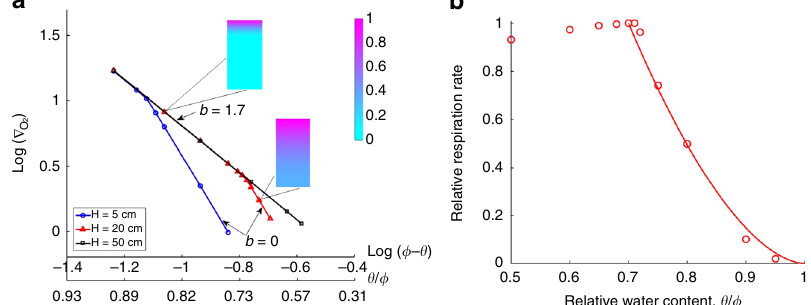
Fig. 3 Effects of O 2 distribution on the O 2 supply restriction factor, b , in the simulated homogenous soil cores with different depths. a Change of b with O 2 distribution, b = ω + 3.5, where ω is the slope of log( ∇ O2 ) − log( ϕ − θ ) curves (see Eq. 8 in Methods section). The gradient of O 2 at the soil – atmosphere interface, ∇ O2 , was calculated using the atmospheric O 2 concentration and the simulated O 2 concentration in the top numerical voxels of the soil cores. The inset plots show the distributions of the relative O 2 concentration with respect to the atmospheric O 2 concentration under different relative water contents ( θ / ϕ = 0.85 and 0.68). SOC and microorganisms were completely collocated in the soil cores as in Fig. 2a. b Comparisons between the moisture function, f m , and the simulated heterotrophic respiration (HR) – moisture relationship obtained by the microscale model (see Methods section) for the soil core with a depth of 20 cm. The red circles represent the simulation results, and the solid line represents f m with b = 1.7, which was fi tted via the